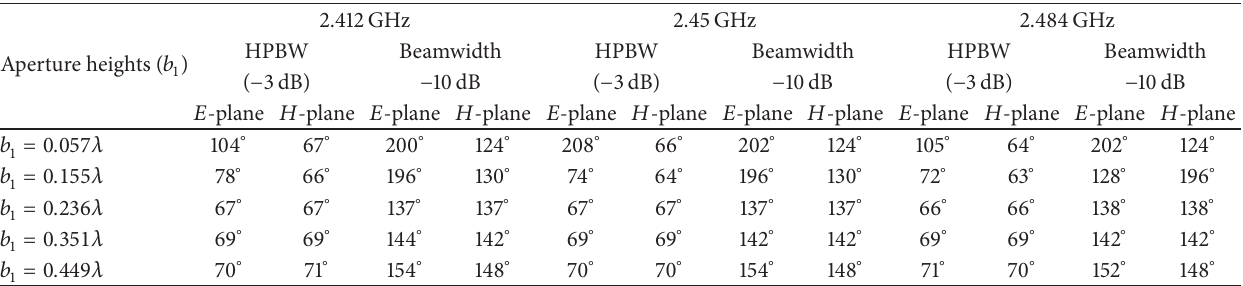
Table 3: Simulated beamwidths at − 3dB and at − 10dB for various heights of the parasitic coupling apertures ( 𝑏 1 ) in the 𝐸 - and 𝐻 -planes for the lower, center, and upper frequencies of WLAN.